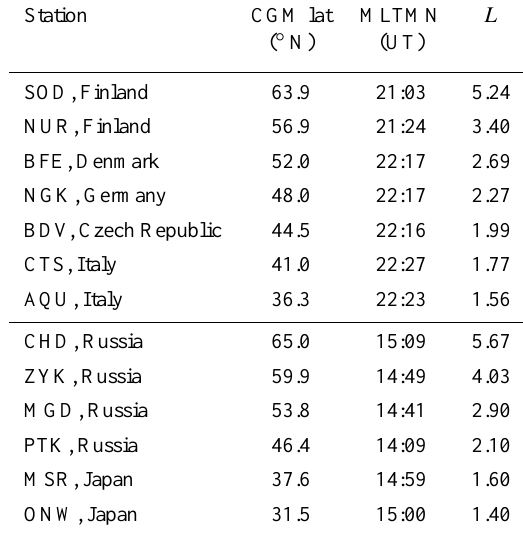
Table 1. IGRF 2000 corrected geomagnetic latitude, MLT midnight in UT and L value for the stations